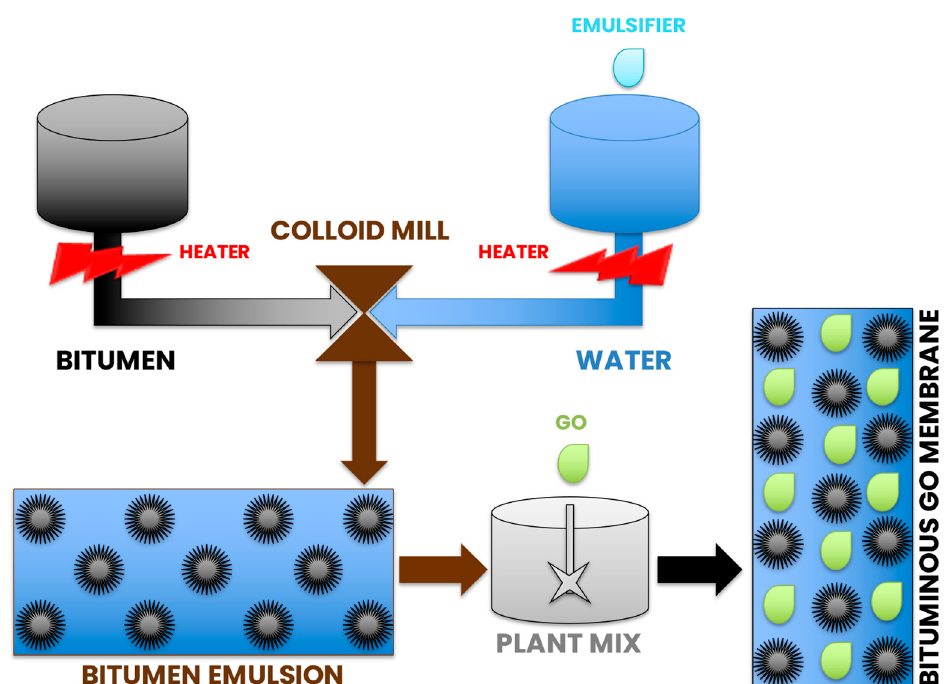
Figure 1. bituminous emulsion preparation